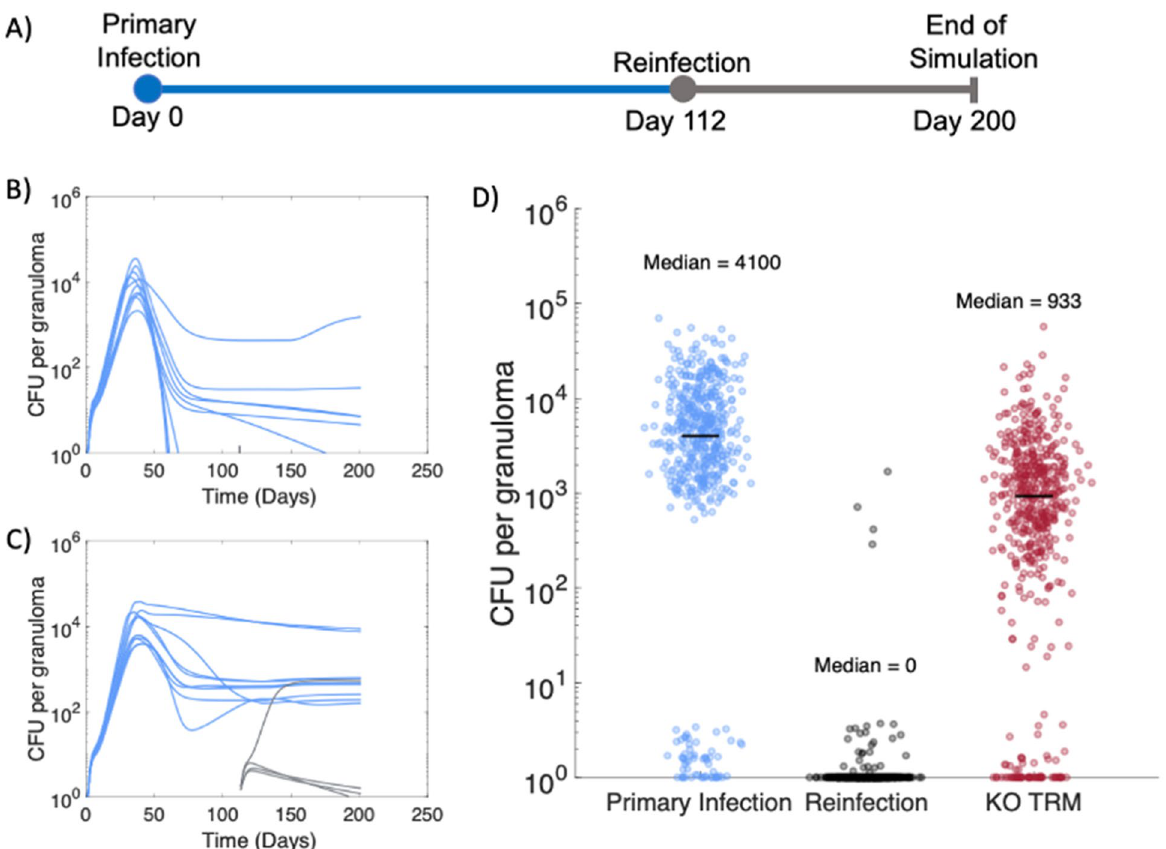
Figure 1. Resident memory T cells protect against establishment of reinfection granulomas in virtual population of 50 hosts. ( A ) Experimental protocol for reinfection study. Primary infection (blue) with 10 CFU inoculum occurred at day 0 and reinfection (gray) with 10 CFU inoculum occurred at day 112, matching the NHP study protocol 32 . Granuloma CFU trajectories from two representative hosts shown in panel ( B ) & ( C ). ( D ) Across 50 virtual hosts, reinfection granulomas exhibit greater sterilization compared to primary infection granulomas 28 days post-infection, as previously observed in NHPs 32 . We re-simulated the same 50 hosts but “knocked-out” (KO) the Trm cell population at reinfection (red data points). CFU per granuloma between KO Trm virtual hosts and the primary infection granuloma CFU was significantly different (Vargha and Delaney’s A measure =